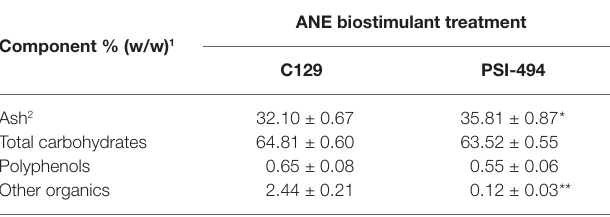
TABLE 1 | Compositional analysis of two ANE biostimulant treatments.